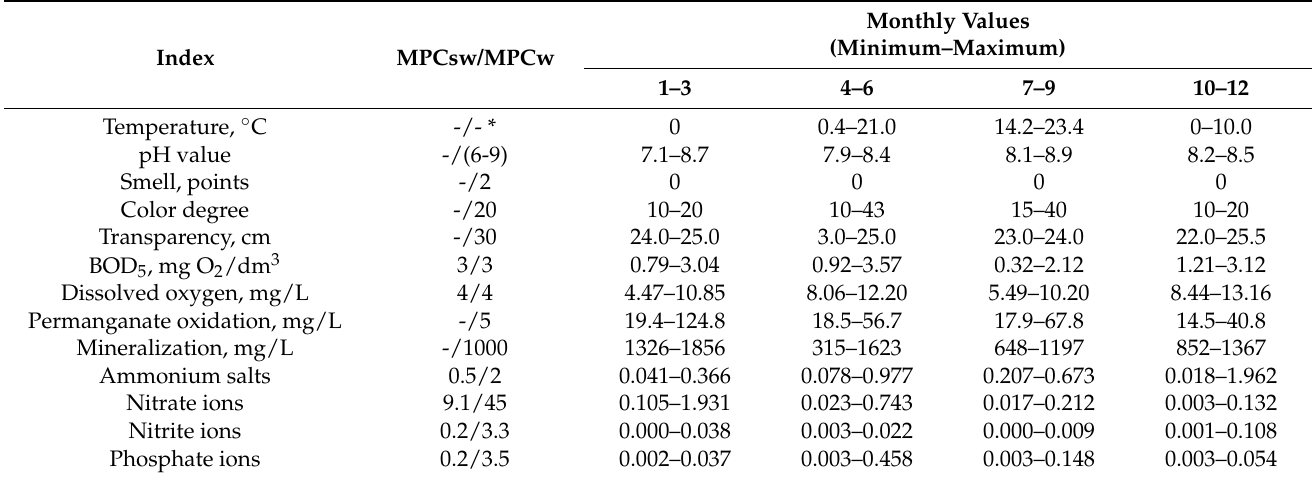
Table 4. Seasonal dynamics of the content of organoleptic, generalized and biogenic elements in the water of the Ishim River for 2013–2019.